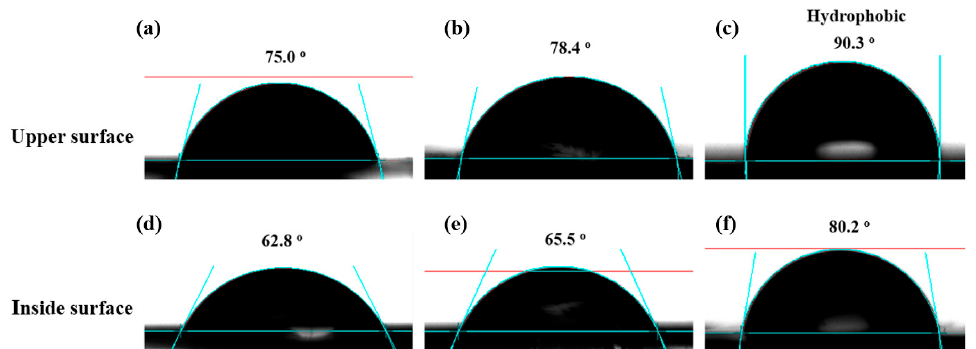
of film. The XPS survey spectra and high resolution C1s spectra for the upper and inside surface of film are shown in Figure 7. The signals of C–O locate at binding energy of 286.3 eV and the peak at 289.1 eV shows the presence of COO + NH–C( = O)–O. The signal at 284.7 eV is corresponded to the other aliphatic and cycloaliphatic carbons [35,36].